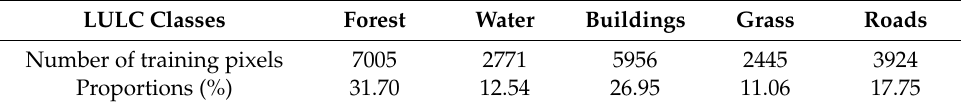
Table 1. Numbers and proportions of training pixels of individual land-use/land-cover (LULC) classes.